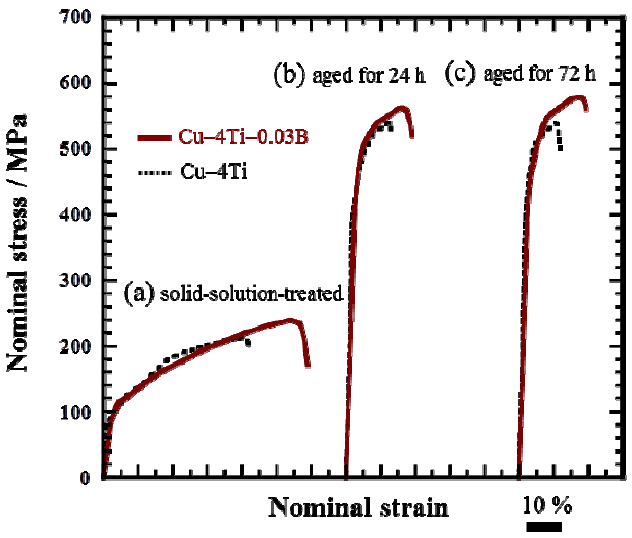
Figure 5. Stress–strain curves of Cu–4Ti–0.03B and Cu–4Ti alloys: ( a ) solid-solution-treated (as-quenched) and aged at 450 °C for ( b ) 24 and ( c ) 72